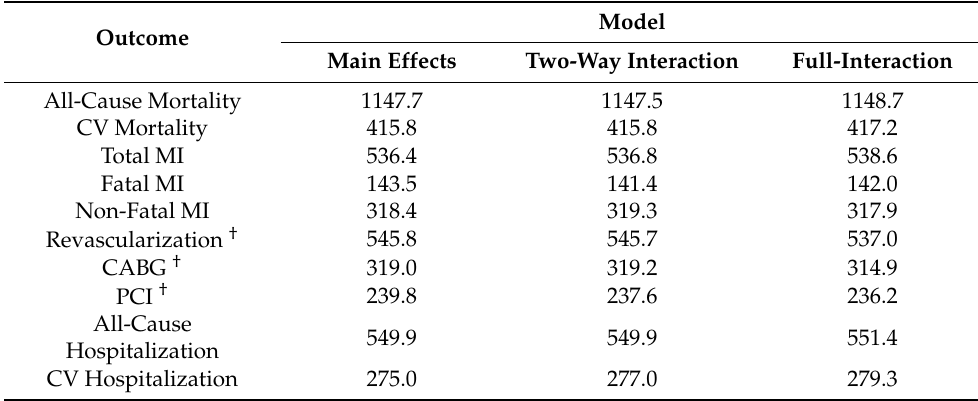
Table 2. Deviance Information Criterion by Model and